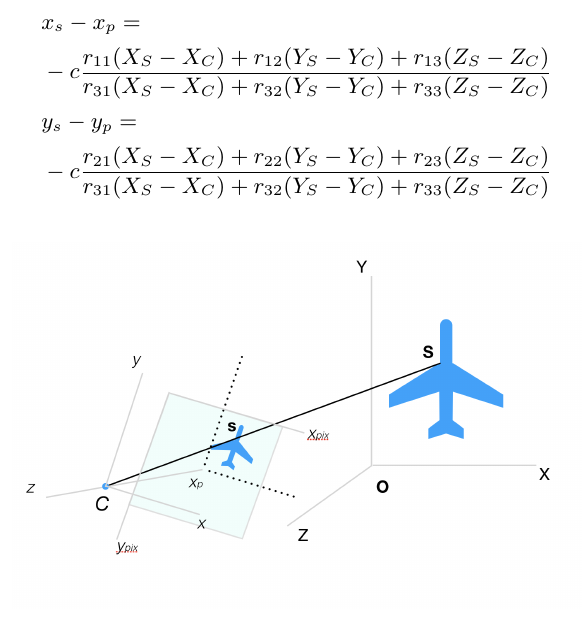
Figure 3. Light ray path for the case of single